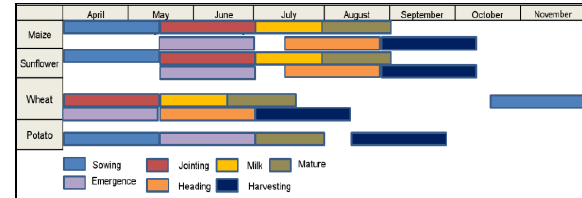
Figure 2. Seasonal maize, sunflower, wheat and potato calendar in the study area